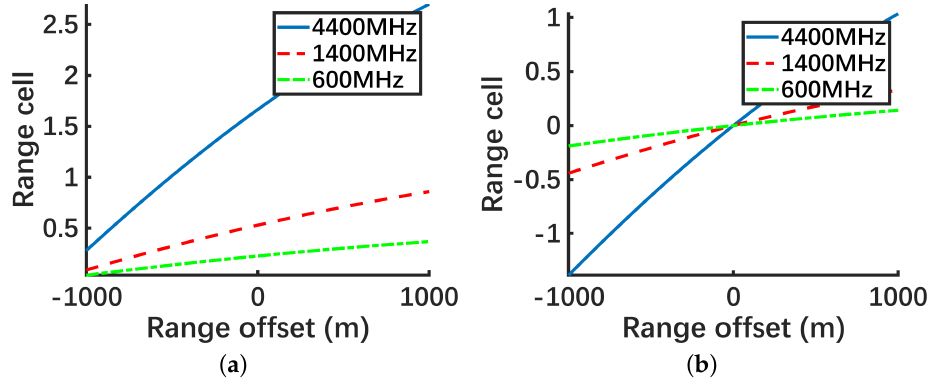
Figure 2. Instances of the LOS displacement and residual LOS displacement with traditional OSM ( a ) LOS displacement ( b ) residual LOS